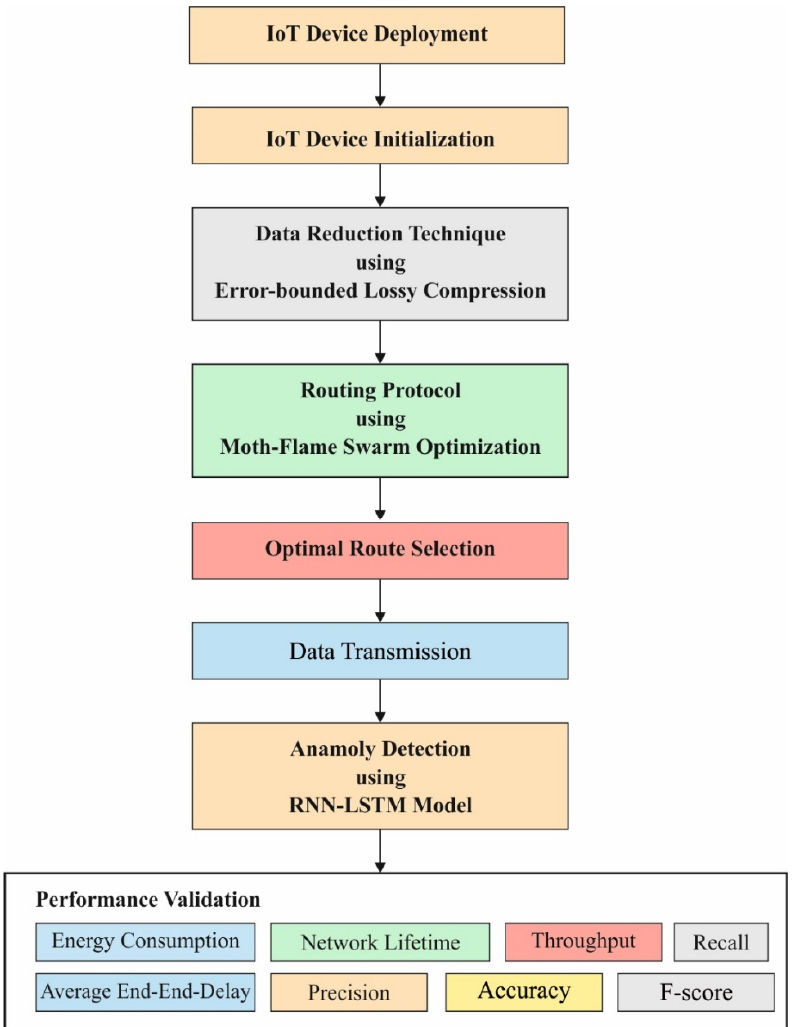
Figure 2. The overall working process of GEER-DLAD model.